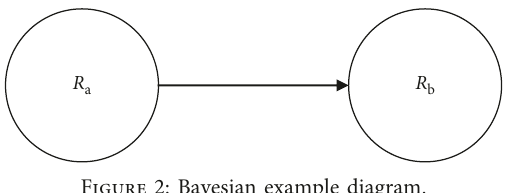
Figure 2: Bayesian example